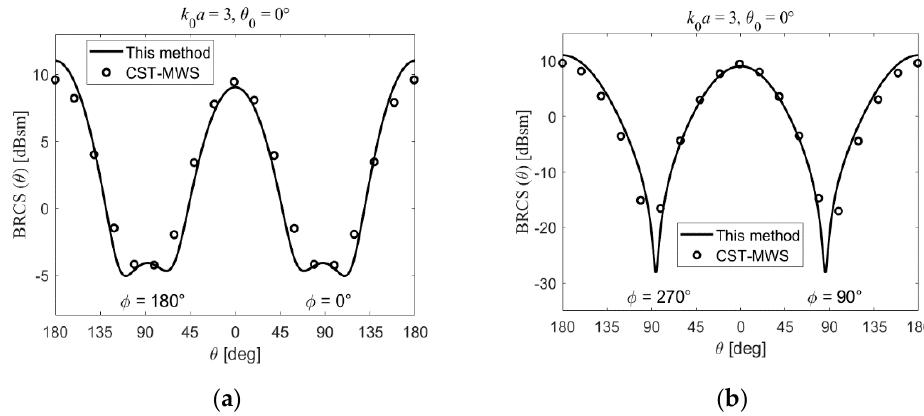
Figure 4. BRCS ( a ) along the x axis and ( b ) along the y axis, for a disk with k 0 a = 3, τ = 0.05 a , ε = ( 10.5 − j 0.3 ) ε µ = µ θ = 0 ◦ , E = E 0 ˆ y . Lines: this method; symbols: data from CST-MWS.